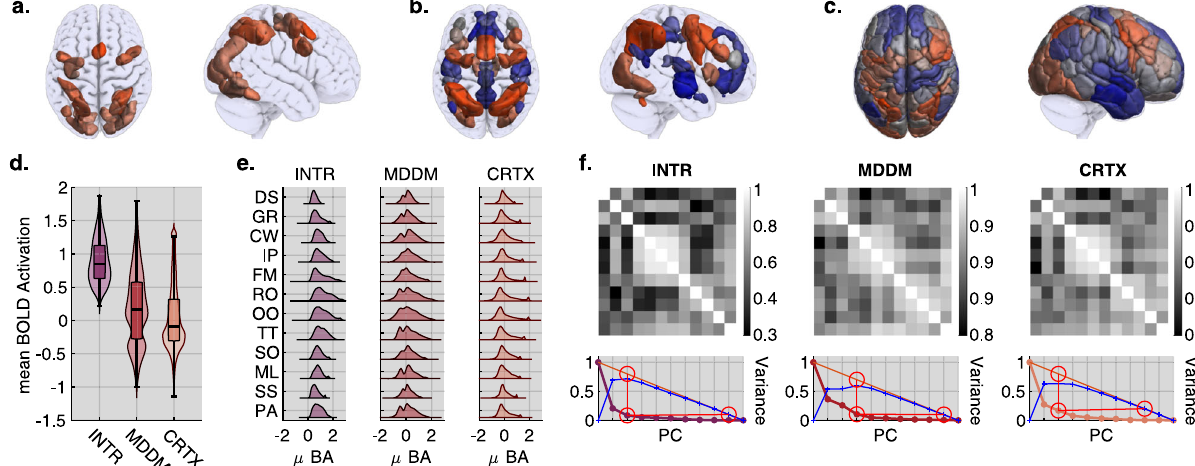
Fig. 2 Functional heterogeneity within ROI sets. a – c Top panel shows the region of interest parcellation sets colour coded to re fl ect task positive (orange) or negative (blue) associations quanti fi ed using mean activation for each ROI. a The intersection conjunction was segmented using our in-house watershed algorithm. b The task negative to positive 20 statistical volume was segmented using the same method. c Unbiased ROI set capturing the whole cortex as de fi ned by 24 during resting state fMRI. d Using the above ROI sets we use custom box-violin plots to show the grand mean voxel-wise activation distribution contained within each brain mask (boxes height is de fi ned as the inter quantile range (IQR); i.e. the range from the 3rd to the 1st quantile, the median is drawn as the central line. Lower inner fence is de fi ned as the 1st quantile minus 1.5 times IQR; upper inner fence is de fi ned as the 3rd quantile plus 1.5 times IQR. Finally, the violin plot is calculated from the winsorized kernel density distribution. Full code is avaliable in the GitHub repository under fws.plot.group_violin.m. As expected, the INTR contains only positive values, the MDDM has a bimodal distribution re fl ecting the task positive and negative networks it captures; and the CRTX mask has a skewed unimodal distribution spanning positive and negative values with a long right tail. e Task- wise distribution plots across ROI sets emphasise the heterogeneity of the different tasks. f Top panel shows the pairwise correlation coef fi cient matrices for each ROI set across tasks. Note, the inner clustering of tasks is consistent across ROI sets. f Bottom panel shows scree plots for principle component analysis (PCA) of task × ROI, separately for each ROI set across tasks. Note, the optimal number of principle components needed to explain the variance across tasks is at least three for each ROI set, thereby demonstrating the heterogeneity of their activation responses to different tasks. Source data are provided as a Source Data fi